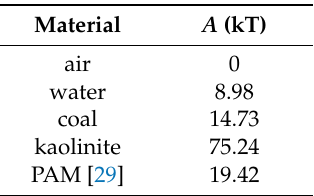
Table 4. The Hamaker constants of materials in a vacuum.